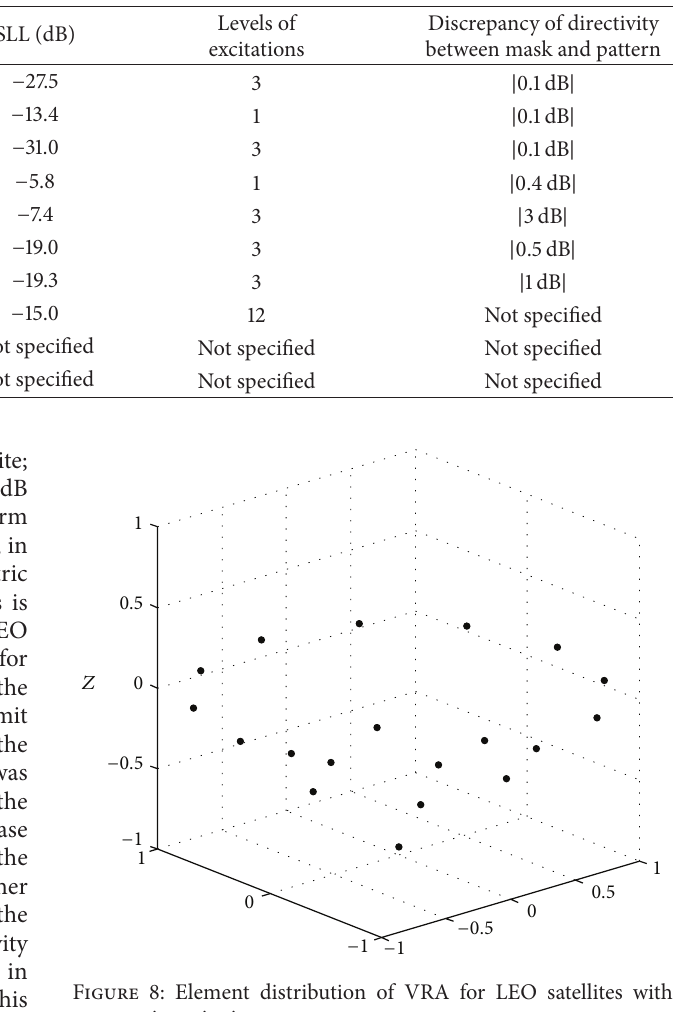
Table 2: Comparison among the obtained designs and previous designs.